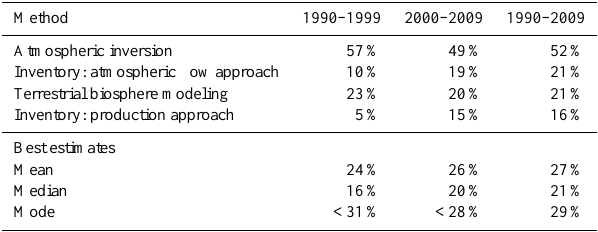
Table 4. Mean annual net land–atmosphere exchange of CO 2 -C for North America by decade as a percentage of North American fos- sil fuel emissions (from Table 3). Note that these are independent proportions and do not add up to